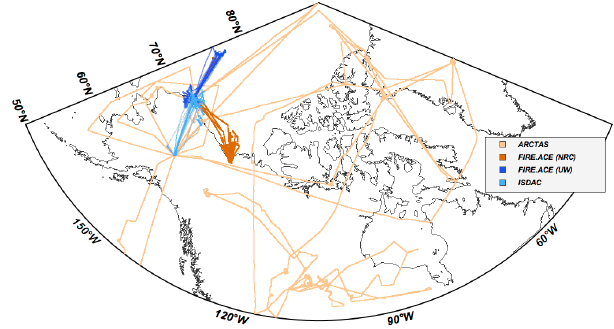
Figure 1. Sampling locations for the following campaigns: ARC- TAS (light orange), NRC FIRE.ACE (dark orange), UW FIRE.ACE (dark blue), and ISDAC (light blue). The locations of clouds sam- pled are shown in Fig.